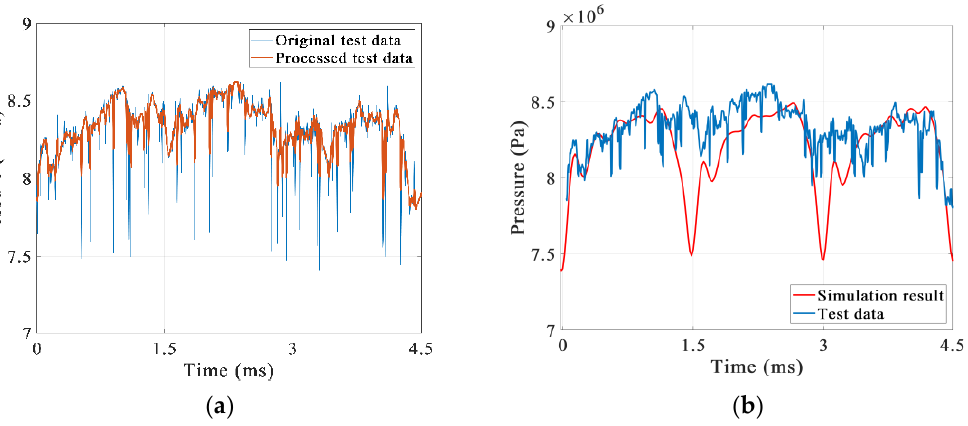
Figure 22. The comparisons ( a ) between the original test data with the processed test data and ( b ) the measured outlet pressure ripple with that obtained by numerical calculation.